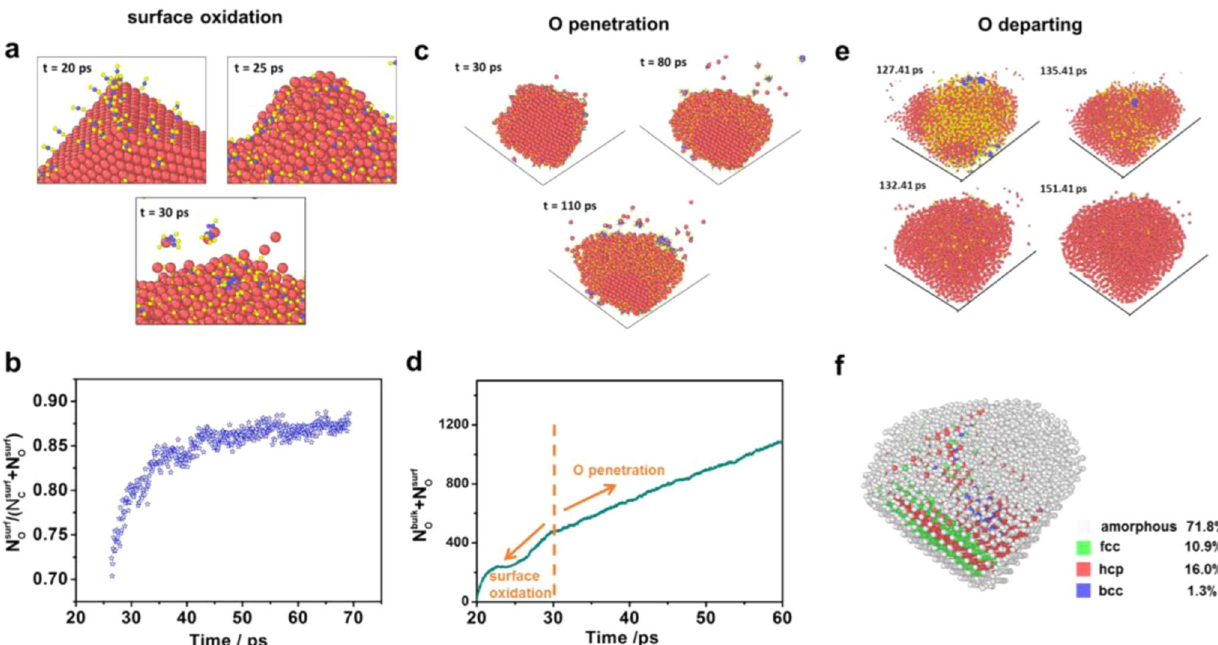
Fig.2|Thesimulatedmechanismfortheamorphization.a Thesnapshotsofthe surfaceoxidationprocess. b ThefractionofsurfaceOinthetotalnumberofsurface C and O. c The snapshots of the slices ofO atomspenetration process. d The time- dependent total number of the O thatbind with Cu, including the O on the surface